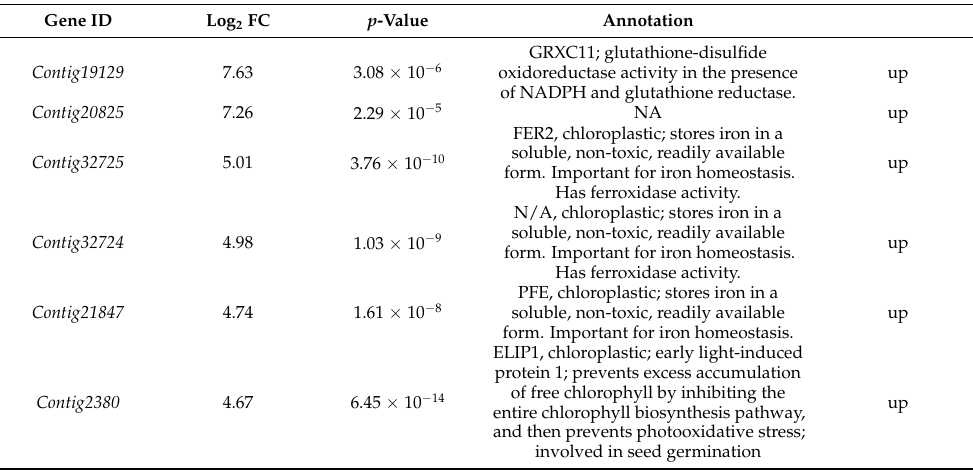
Figure 3. Overview of transcriptome analysis. ( A ) Venn graph for 24 h and 72 h based on heat downregulated (repressed) genes. ( B ) Venn graph for 24 h and 72 h based on upregulated (induced) genes. ( C ) The heatmap of the DEGs in RNA-seq analysis. CK: control for 0 h; H24h: heat stress for 1 h; H72h: heat stress for 72 h. Table 2. Top 20 DEGs in red pitaya after heat